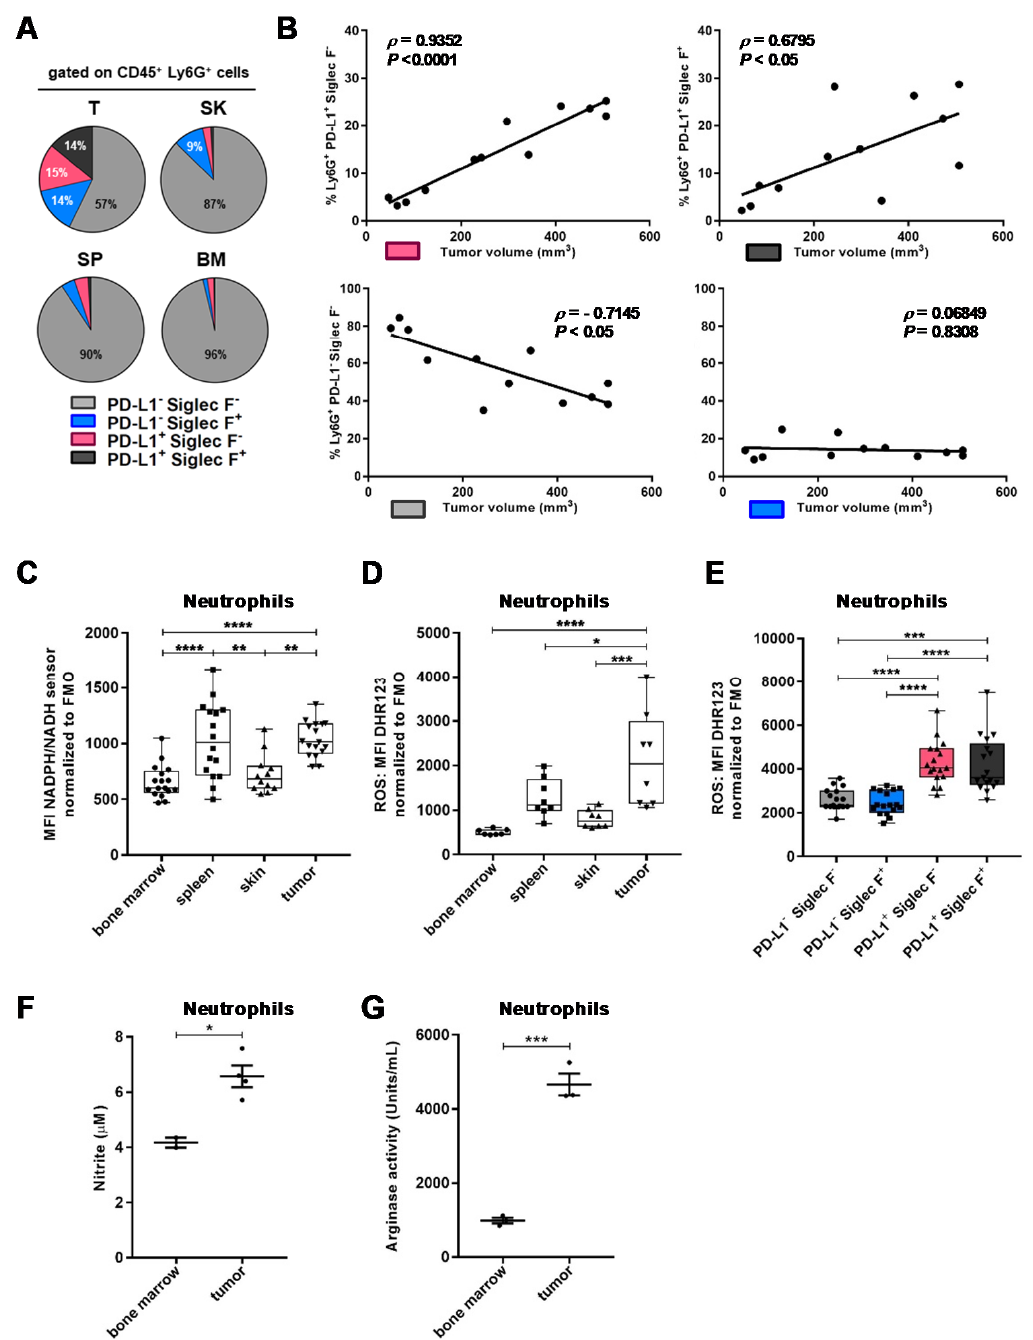
Figure 3. Phenotype and function of TANs infiltrating mSCC38 tumors. ( A ) Proportions of neutrophils expressing either PD-L1 and Siglec F alone or together or none of them, day 30 post-intradermal implantation ( n = 5–12 mice, mean ± SEM (standard error of mean) from two independent experiments). PD-L1 − Siglec F − from tumors was significantly downregulated compared to the other subsets, **** p < 0.0001; PD-L1 + Siglec F − from tumors was significantly upregulated compared to skin and BM (bone marrow), * p < 0.05; PD-L1 + Siglec F + from tumors was significantly upregulated compared to skin and spleen, * p < 0.05 and to BM, ** p < 0.01; PD-L1 − Siglec F + from tumors was significantly upregulated compared to BM, * p < 0.05; Two-way ANOVA. ( B ) Correlation between the frequency of infiltrating PD-L1 + Siglec F − , PD-L1 + Siglec F + , PD-L1 − Siglec F − , and PD-L1 − Siglec F + neutrophils and tumor size ( n = 12). Linear regression curve, spearman r value, and p value (95% confidence interval) are shown. ( C ) Intracellular NAD(P)H (reduced nicotinamide adenine dinucleotide phosphate) levels and ( D ) ROS (reactive oxygen species) production in neutrophils from the BM, spleen, skin, and tumor from mSCC38-bearing mice ( n = 8–17 mice, mean ± SEM from two or three independent experiments), * p < 0.05, ** p < 0.01, *** p < 0.001, **** p < 0.0001 Kruskal–Wallis one- way ANOVA. ( E ) ROS production in TANs from mSCC38-bearing mice day 30 post-intradermal implantation ( n = 17 mice, mean ± SEM from three independent experiments), *** p < 0.001, **** p <